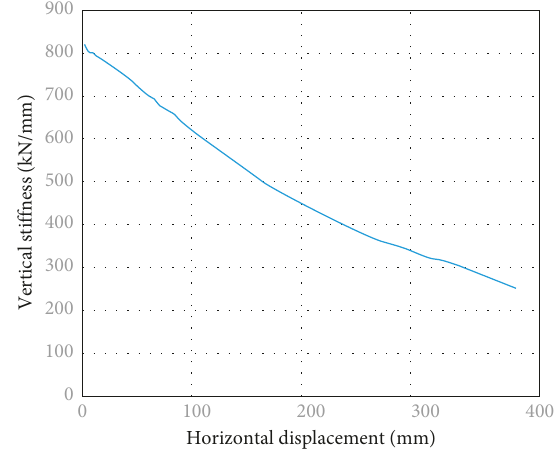
Figure 17: Relationship between vertical stiffness and horizontal